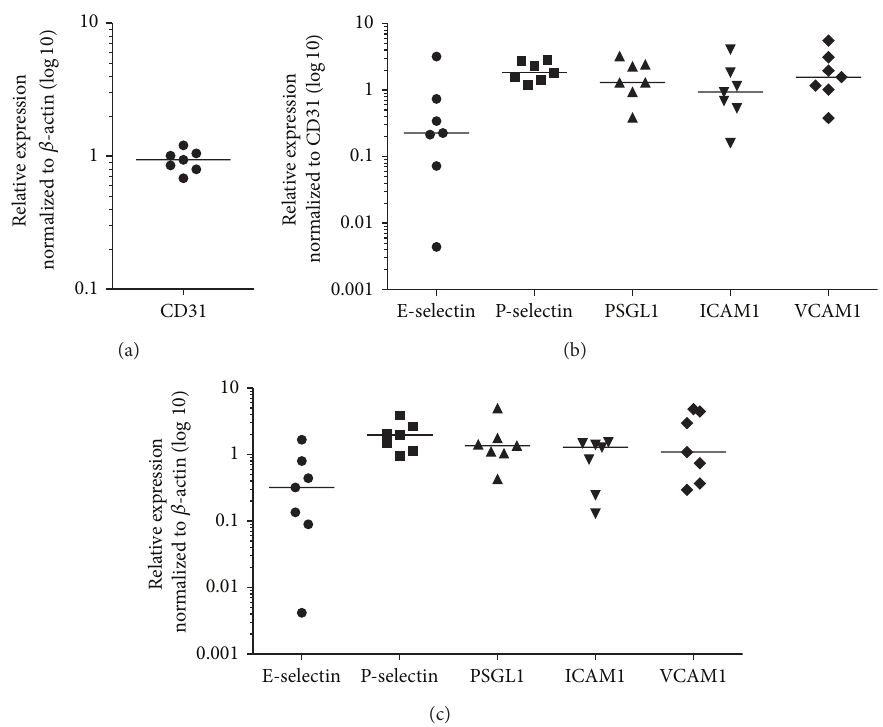
Figure2:ScatterplotsofCD31andadhesionmoleculeexpressioninnasalpolypscomparedtoassociatedinferiorturbinatesusingqPCR.Each single dot shows the relative expression of the target molecule in nasal polyps compared to associated inferior turbinates of one patient and median is indicated as horizontal bar . (a) CD31 is not differentially expressed (0.93-fold, 𝑛 = 7 ) between nasal polyps and inferior turbinates; (b) adhesion molecule expression in nasal polyps normalized to CD31. E-selectin (0.22-fold, 𝑛 = 7 ), P-selectin (1.82-fold, 𝑛 = 7 ), PSGL1 (1.29-fold, 𝑛 = 7 ), ICAM1 (0.93-fold, 𝑛 = 7 ), and VCAM1 (1.56-fold, 𝑛 = 7 ). (c) Adhesion molecule expression in nasal polyps normalized to 𝛽 -actin. E-selectin (0.31-fold, 𝑛 = 7 ), P-selectin (1.97-fold, 𝑛 = 7 ), PSGL1 (1.34-fold, 𝑛 = 7 ), ICAM1 (1.28-fold, 𝑛 = 7 ), and VCAM1 (1.08-fold, 𝑛 = 7 ). CD31 normalized data differ insignificantly compared to the 𝛽 -actin normalized